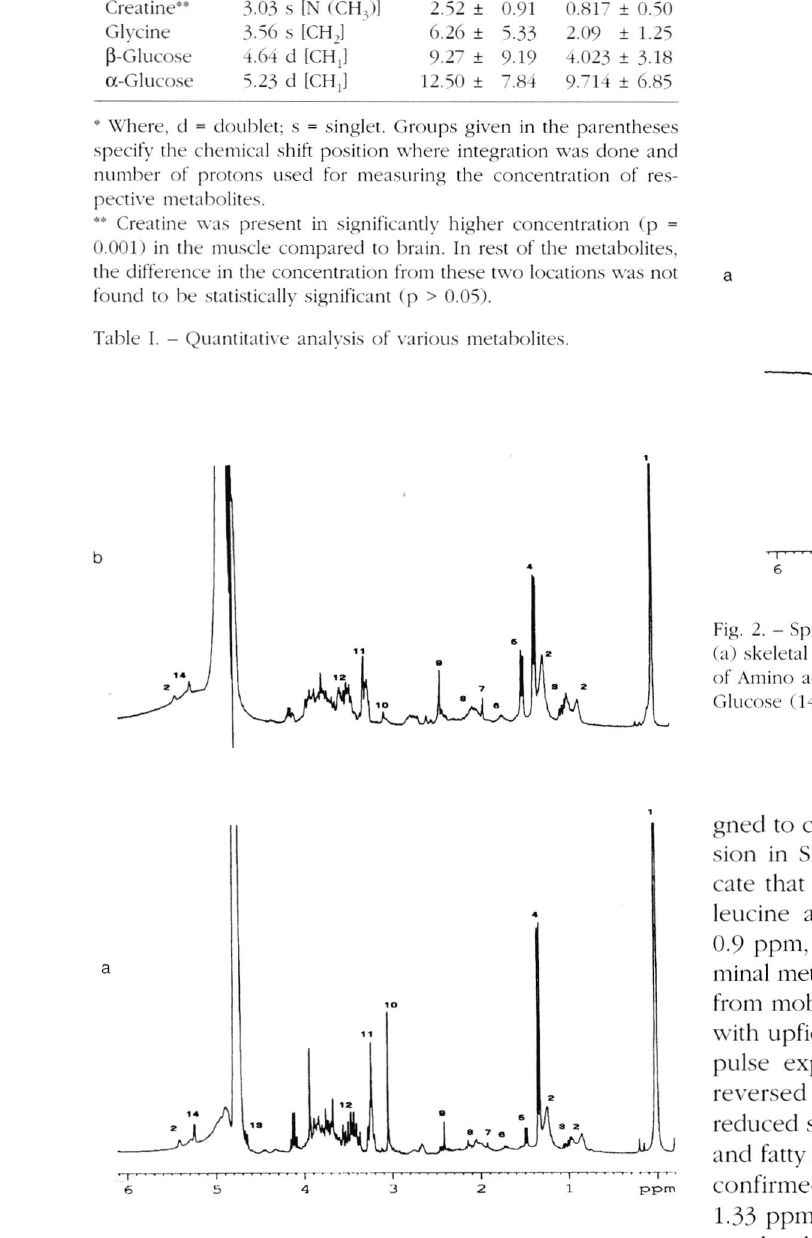
Fig. 1. - Single pulse 1 H MRS of Cysticercus cyst fluid from (a) ske letal muscle and (b) brain of swine showing TSP (1), Lipid (2). Amino acids [Valine (Val). Isoleucine (Ile), and Leucine (Leu); 31. Lactate (4), Alanine (5). Lysine (6), Acetate (7), Glutamate/Glutamine (8), Succinate (9), Creatine (10), Choline containing compounds (11). Glycine (12). b-Glucose (13). a-Glucose (14). Note the large Crea tine peak at 3.03 ppm in (a) compared to (b).